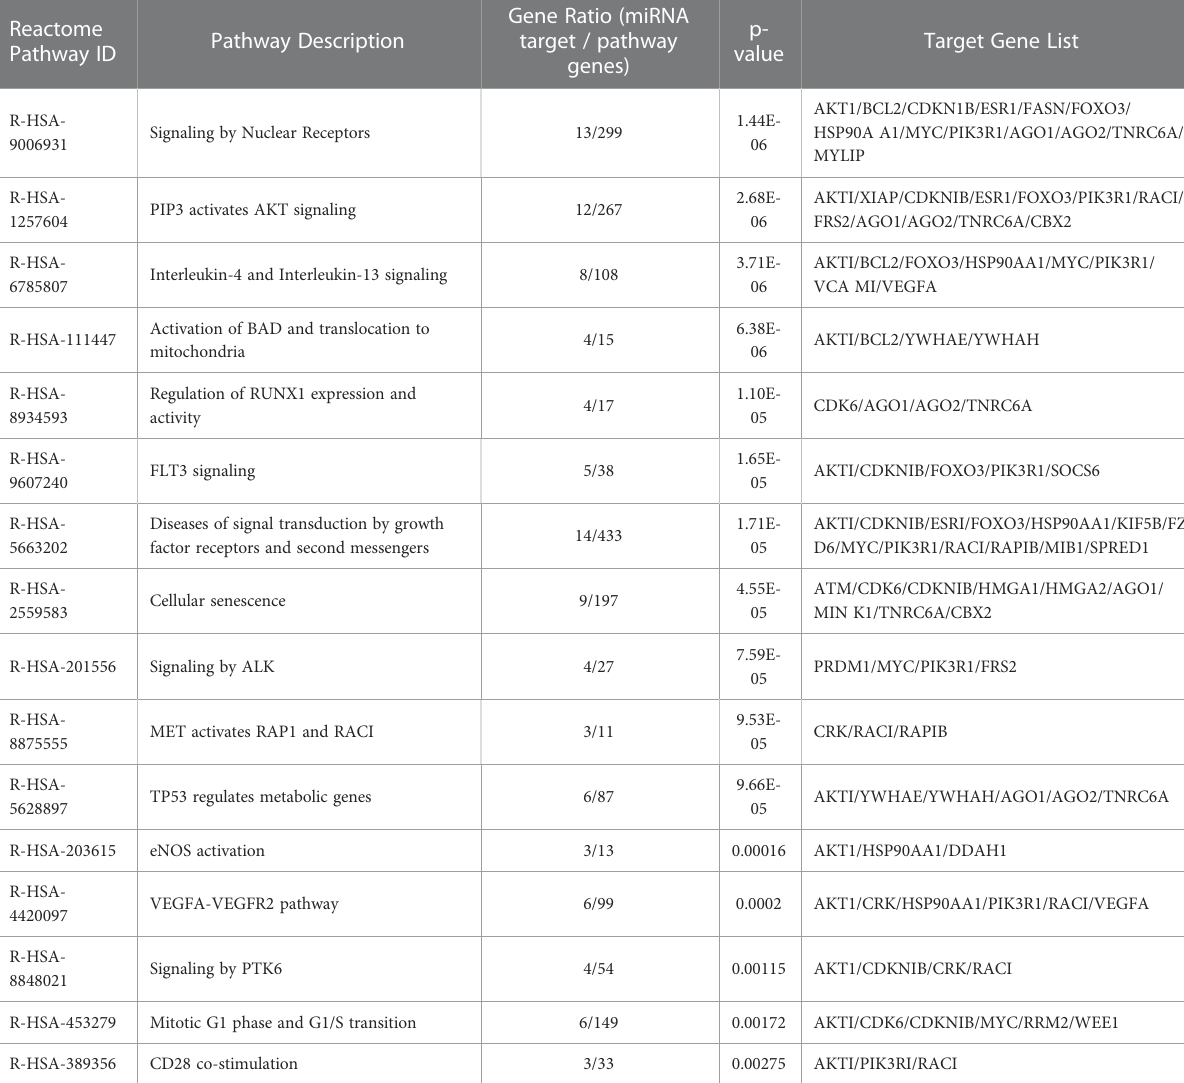
TABLE 5 Representative pathways identi fi ed by the Reactome-PA